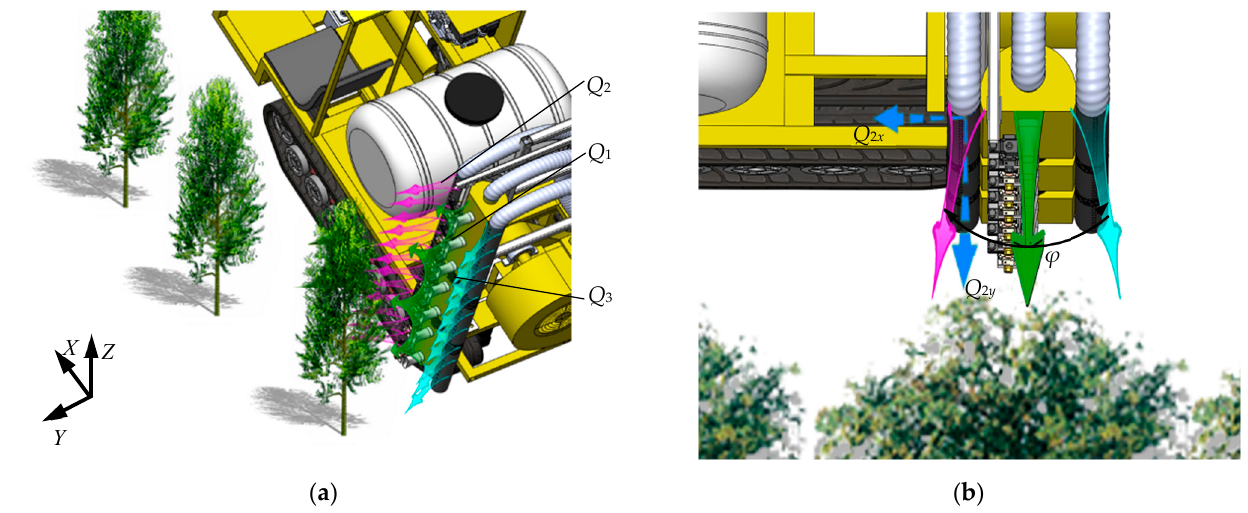
Figure 2. Anti-drift schematic diagram of spray device with multi-airflow synergy. Three-dimensional map of spray operation ( a ); Top view of spray operation ( b ).